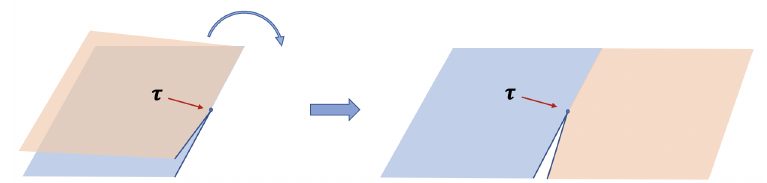
Figure 8. Unfolding an open string joining/splitting operator τ that sews together copies of M + and M − to make an open string that winds once around AdS 3 . Dark edge lines indicate the locus of reflecting boundary conditions, while the absence of such a dark line at the boundary between M + (blue) and M − (red) indicates the locus of transparent boundary